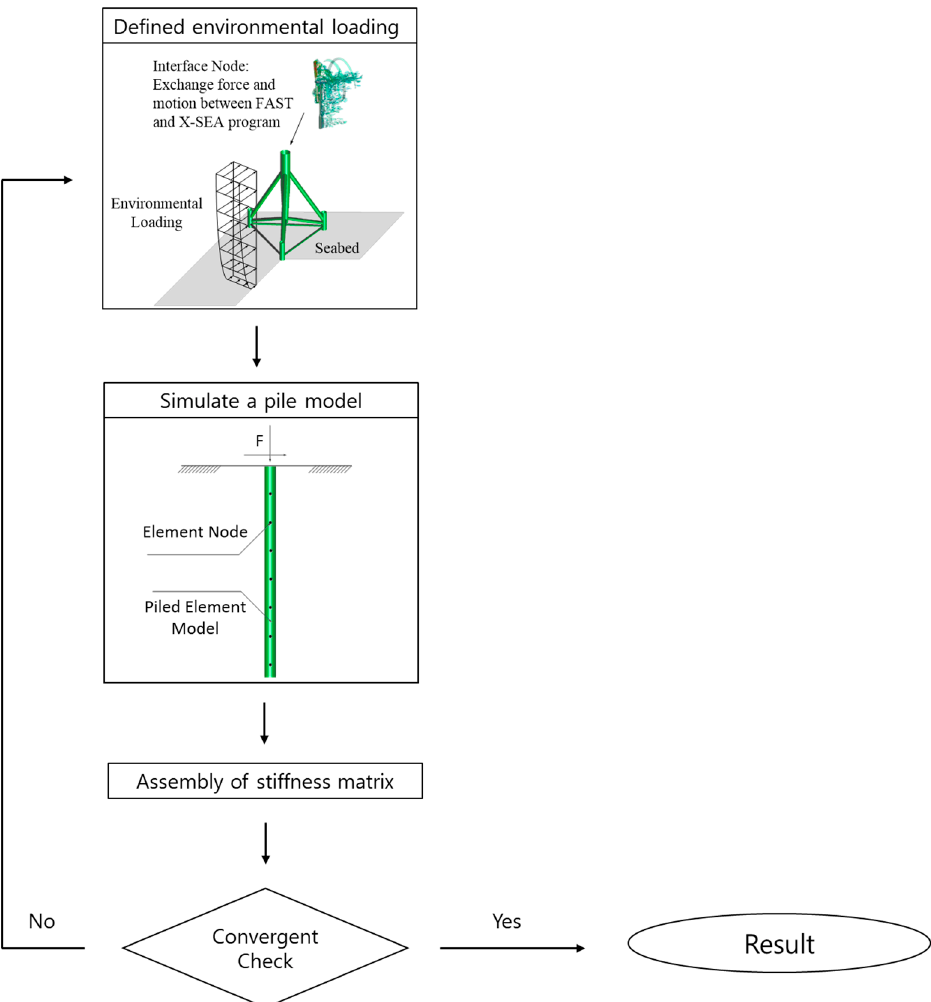
Figure 6. Scheme for coupled analysis of turbine effects including pile-soil-structure interactions.